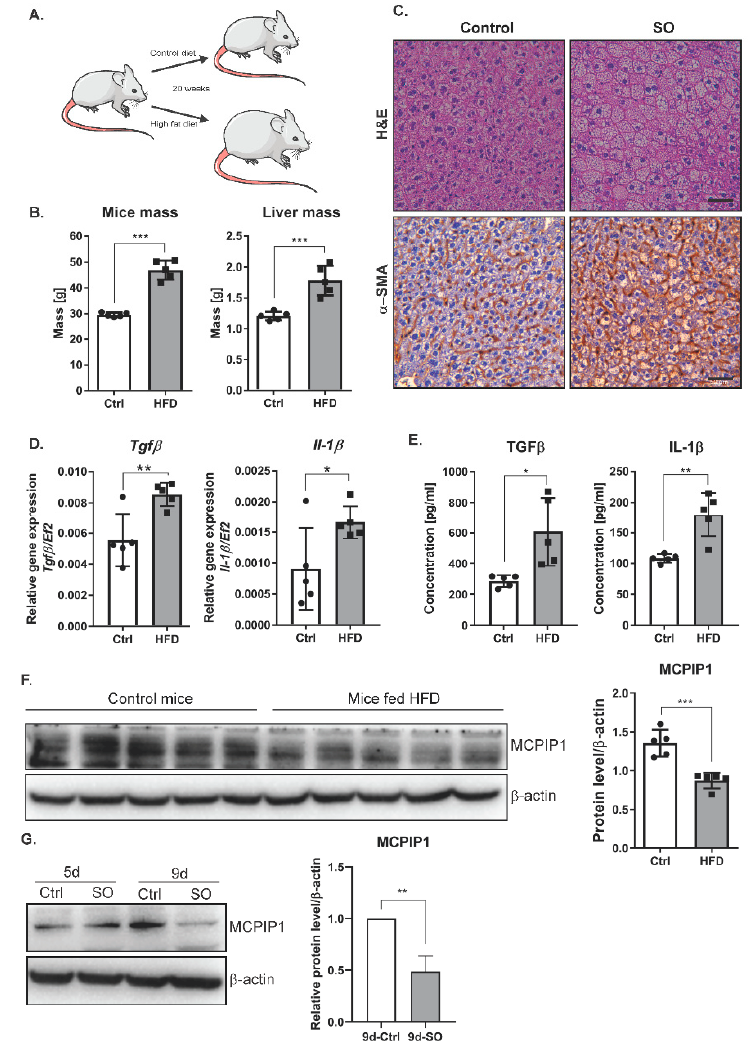
Figure 4. Phenotype of liver cells in the mice fed a high-fat diet (Ctrl, n = 5, HFD, n = 5). ( A ) The scheme of the experiment: 10-weeks-old C57BL/6J mice were fed a control or high-fat diet for 20 weeks. ( B ) Graphs showing mouse body and liver weight due to excessive fat intake. ( C ) Hematoxylin–eosin and α -SMA staining shows changes in the morphology of liver cells in the mice fed a high-fat diet. Immunohistochemical evaluation was performed using primary monoclonal anti-smooth muscle actin antibody (1:100, Dako, Glostrup, Denmark) and EnVision Detection Systems Peroxidase/DAB ((3,3 (cid:48) -Diaminobenzidine) Rabbit/Mouse (Dako), scale bar, 50 µ m ( D ) mRNA expression estimated by real-time PCR for Il-1 β and TGF β in mouse livers, Ctrl—mice on a control diet, HFD—mice fed a high-fat diet. The dots represent individual animals, n = 5. The EF2 gene was used as reference. ( E ) The protein levels of IL-1 β and TGF β in mouse livers were obtained using ELISA. Ctrl—mice on a control diet, HFD—mice fed a high-fat diet. The results are presented as the means ± SD. The dots represent individual animals, n = 5. ( F ) Left panel, representative Western blot of the MCPIP1 level in mouse livers. Ctrl—mice on a control diet, HFD—mice fed a high-fat diet. Right panel, densitometric analysis of the MCPIP1 level in mouse livers. The dots represent individual animals, n = 5. ( G ) Left panel, representative Western blot of the MCPIP1 level in the Huh7 cells stimulated with sodium oleate for five (5d) and nine (9d) days; β -actin was used as the loading control. Right panel, densitometric analysis of three independent experiments. The results are presented as the means ± SD, the Student’s t -test was used to determine the p -value, * p < 0.05; ** p < 0.01; *** p < 0.001. 2.5. NAFLD in Mice Increases the Levels of β -Catenin and Activates the EMT Program